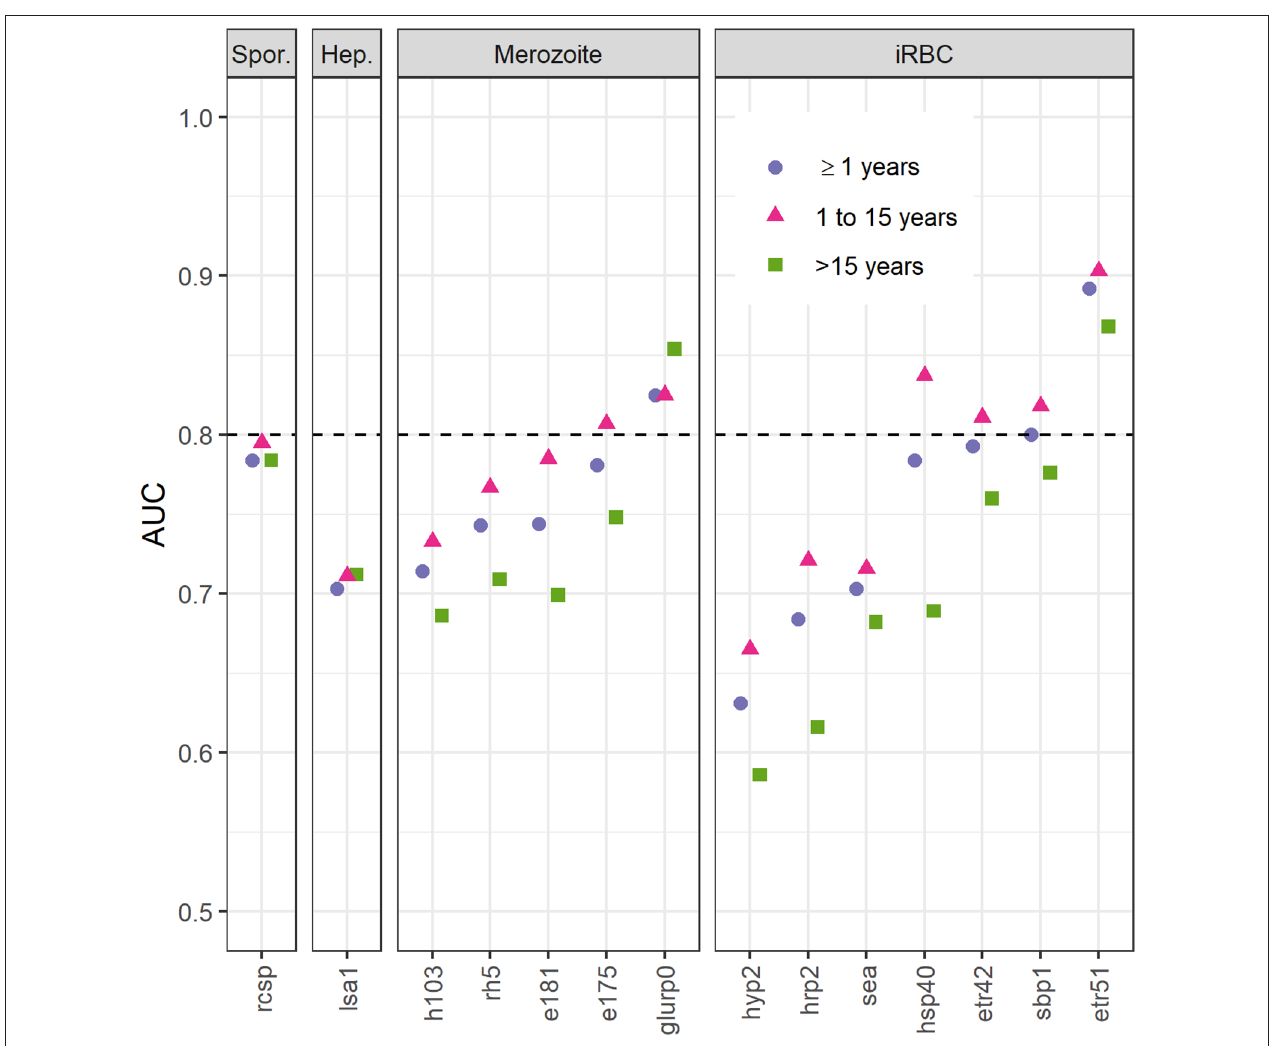
FIGURE 2 | Area under the curve (AUC) of receiver operating characteristic curves for immunoglobulin G (IgG) responses to fourteen Plasmodium falciparum antigens using highly sensitive rapid diagnostic test (hsRDT) status as the gold standard. Antigens (x-axis) are ordered by parasite life cycle stage and AUC value for all ages. IgG responses (IgG) in two-thirds of all EAG-Grand’Anse participants were used (i.e., the training dataset; n = 3,201) including 227 hsRDT positives (7.1%). IgG responses were defined as log10-transformed median fluorescence intensities corrected for background reactivity. A threshold of 0.8 (dashed horizontal line) was used to select antigens for confirmation of results in the remaining one-third of the EAG-Grand’Anse dataset (see Figure 3 ). Spor.: sporozoite; Hep.: infected hepatocyte; iRBC: infected red blood